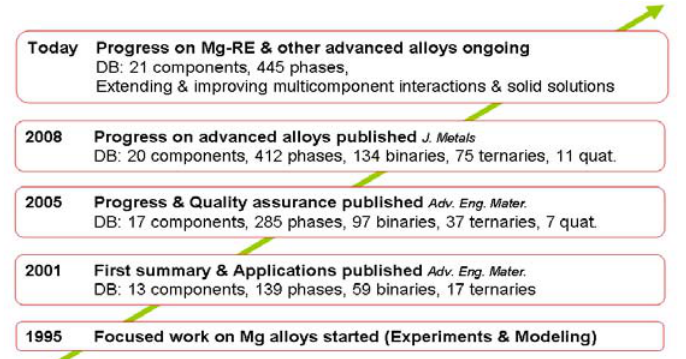
Figure 1. Milestones during the Mg alloy database